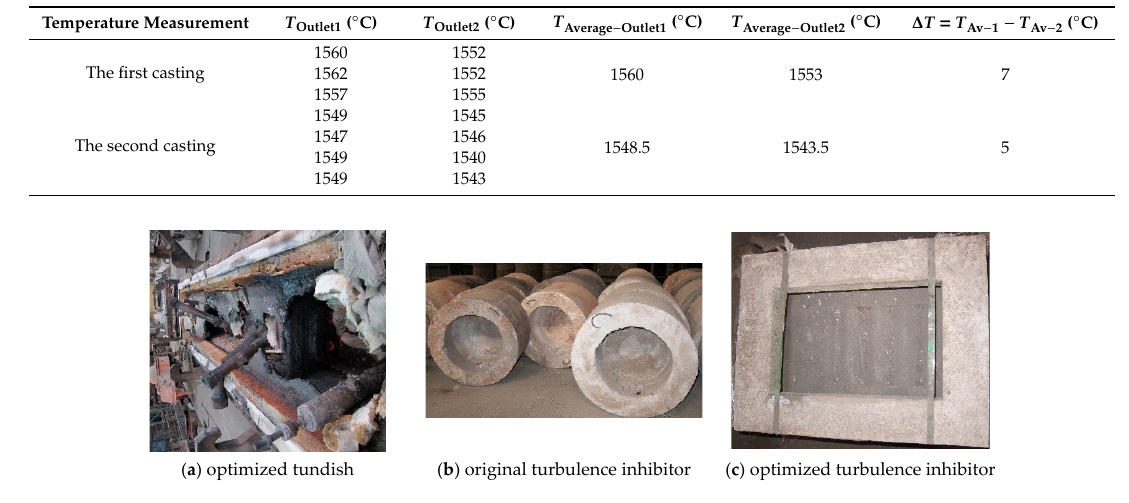
Figure 16. Industrial tundish.